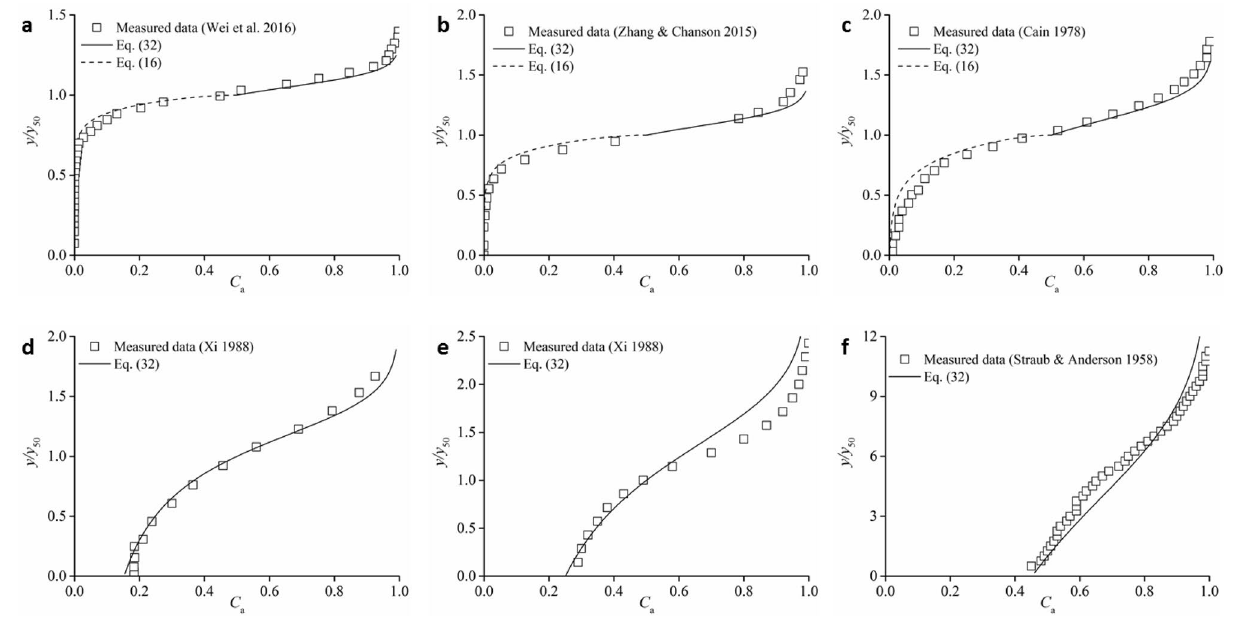
Figure 5. Comparison of calculated C a profiles with the measured air concentration distribution in self-aerated open channel flows. ( a ) C mean = 0.15 (smooth channel). ( b ) C mean = 0.21 (stepped channel). ( c ) C mean = 0.32 (smooth channel). ( d ) C mean = 0.41 (smooth channel). ( e ) C mean = 0.54 (smooth channel). ( f ) C mean = 0.65 (smooth